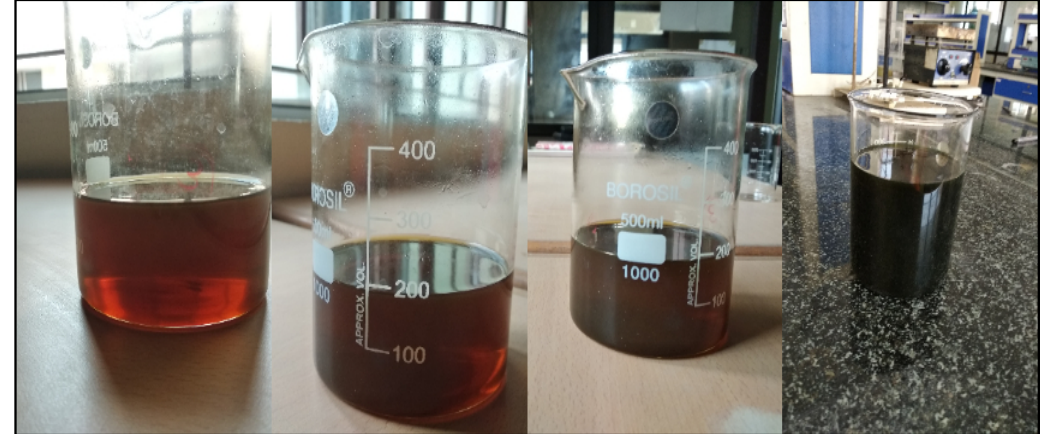
Figure 1. Transformer oil samples with 0%, 0.01%, 0.03%, and 0.05% weight percentage concentration of graphene nanoparticle.